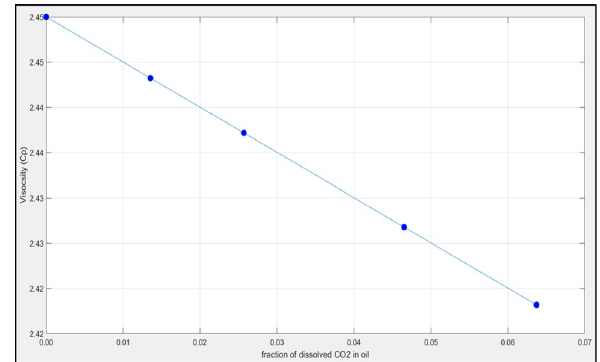
Table 3 Comparison of daily oil production within conventional method and CO 2 flood 2 and